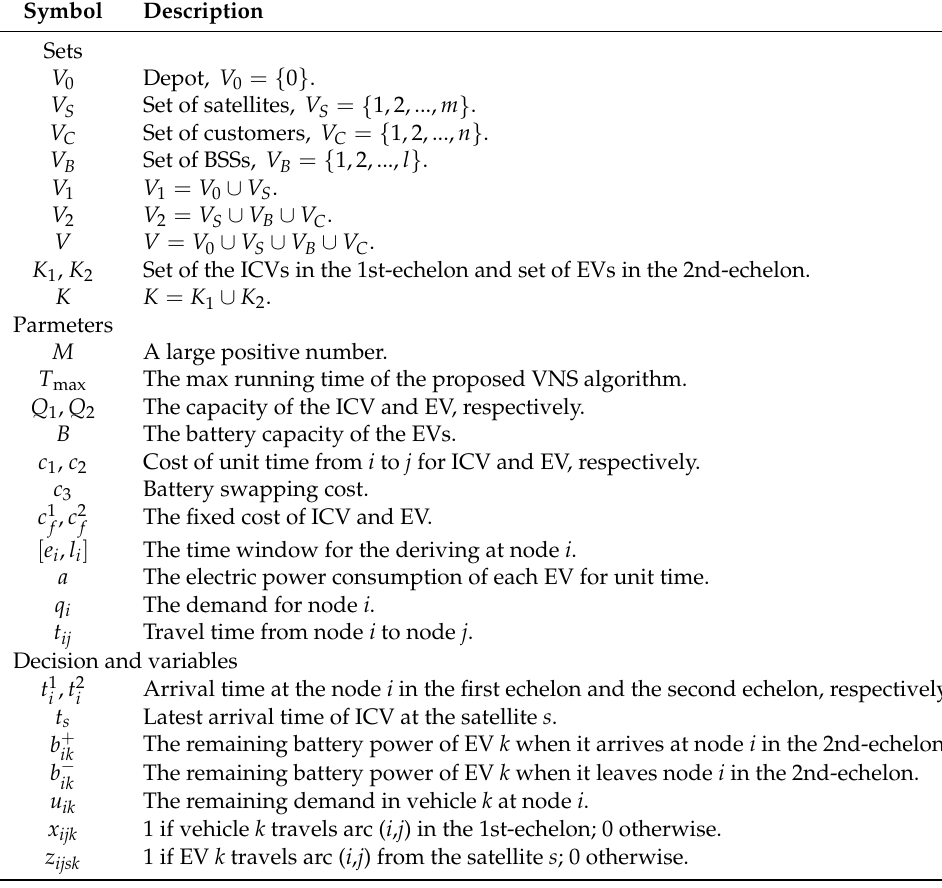
Table 1. Variables and parameters of the